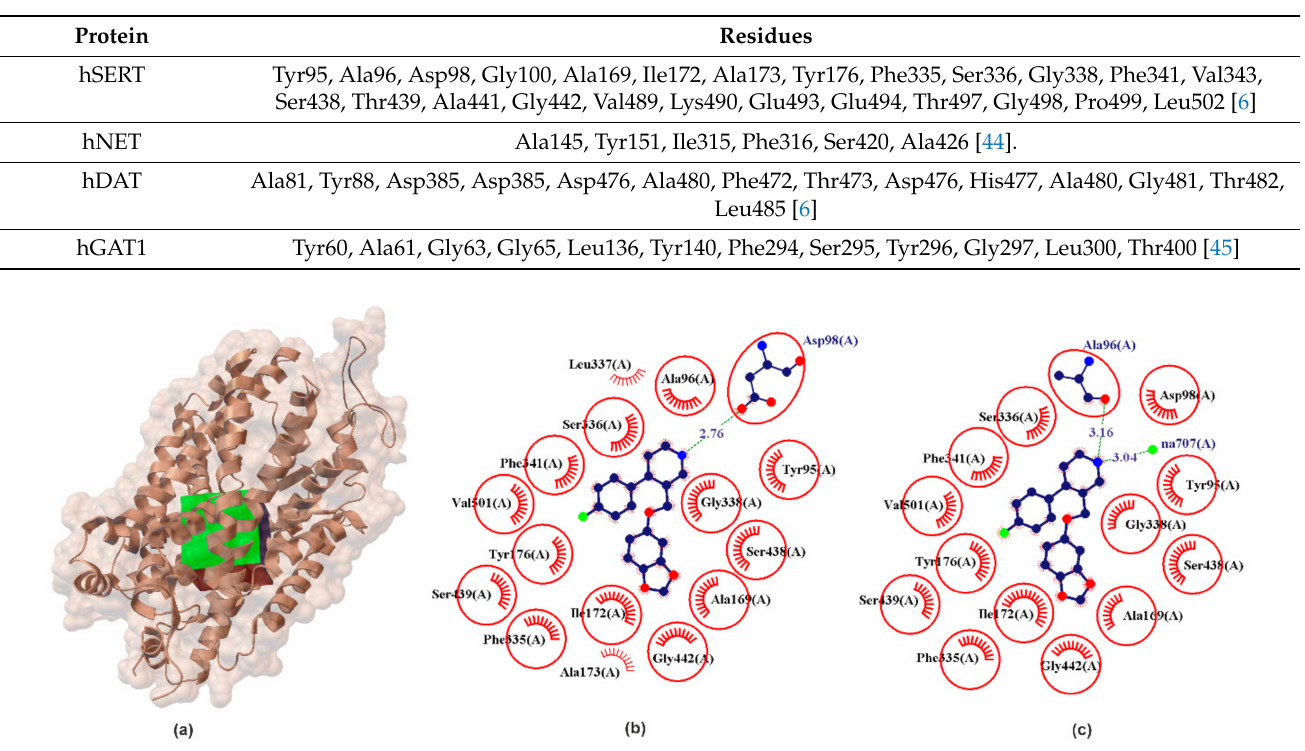
Table 2. The composition of the binding pocket of the analyzed channel models: hSERT, hDAT, hNET, hGAT1.